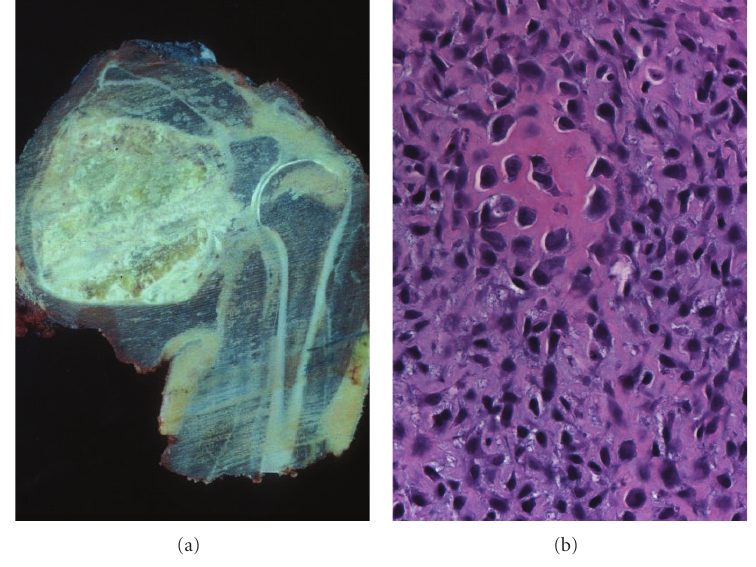
Figure 3: Osteosarcoma: (a) gross photograph of resected specimen demonstrating a large lesion in scapula extending into soft tissue. (b) Representative microscopic section showing pleomorphic and spindle cells with hyperchromatic nuclei and osteoid production. (H&E. 200 ×